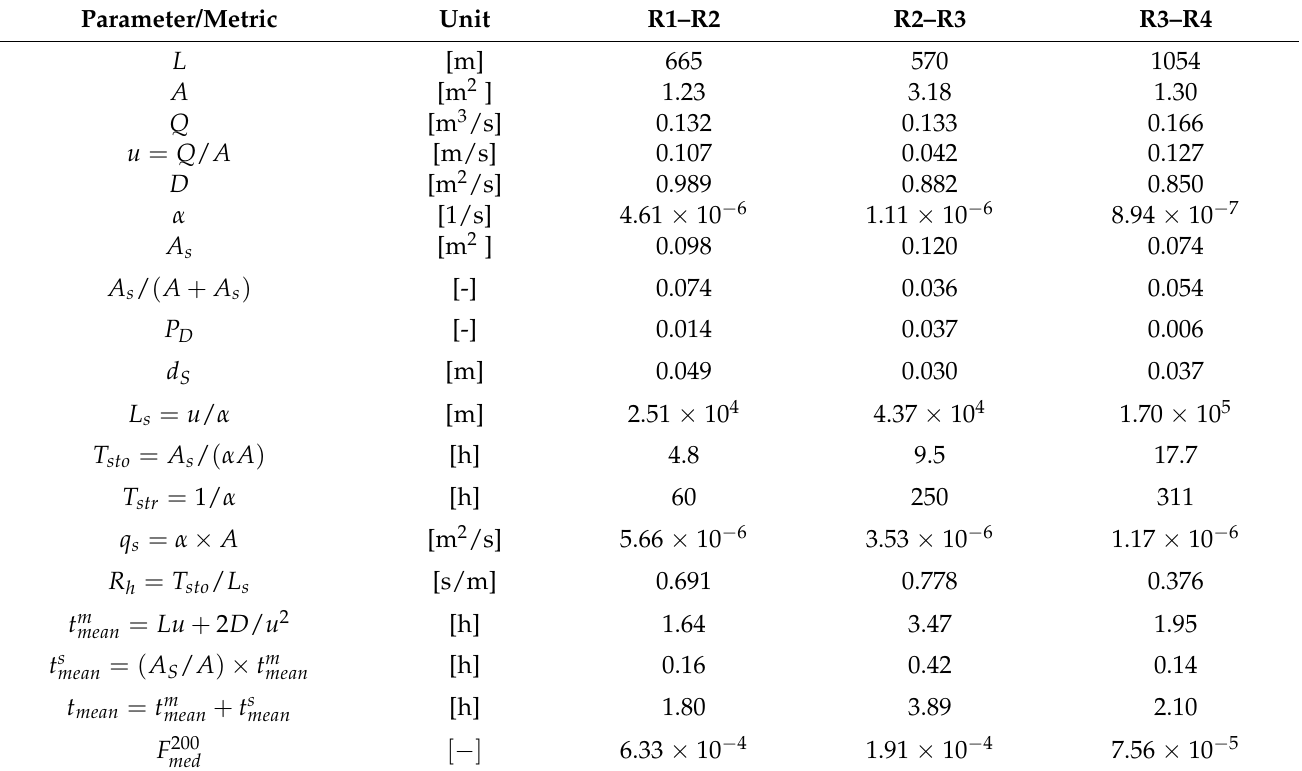
Table 4. Parameters and metrics of transient storage derived from 3 H BTCs. See Appendix C for explanation of symbols.